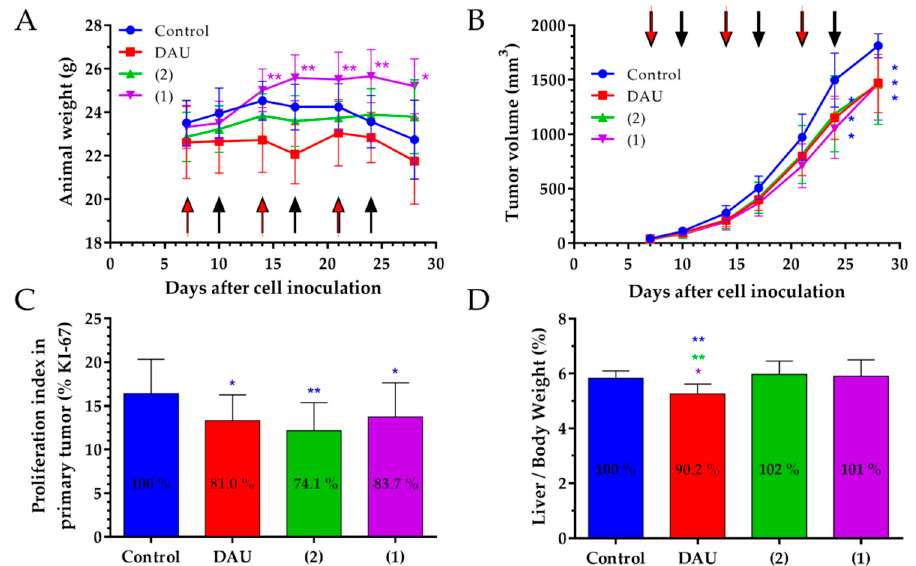
Figure 4. Effect of GnRH-III-Dau conjugates 1 and 2 (10 mg/kg Dau content, 6 treatments, black arrows) and free Dau (1 mg/kg, 3 treatments, red arrows) in orthotopic 4T1 mice breast carcinoma bearing mice. ( A ) Animal body weight (grams, average ± SD). ( B ) Tumor volume (mm 3 , average ± SD). ( C ) Proliferation in primary tumor (average proliferation index ± SD). ( D ) Liver weight/body weight ratio (percentage, average ± SD) after termination of experiment, 28 days subsequent to cells inoculation, 7 animals per group, statistical analysis was performed by Mann–Whitney test. * and ** mean significant at p < 0.05, p < 0.01 and p < 0.001, respectively. * blue, purple, and green mean significant difference in control, 1 , and 2 groups, respectively, at the end of experiment compared to the start (A), and significant difference compared to control, 1 , and 2 groups respectively (B,C,D).